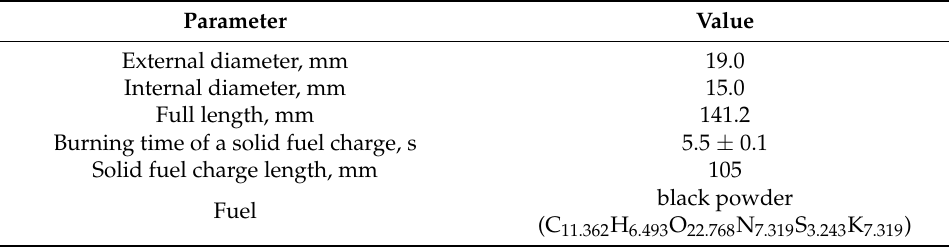
Table 1. Characteristics of the model SRM E-5-0 used in the work.